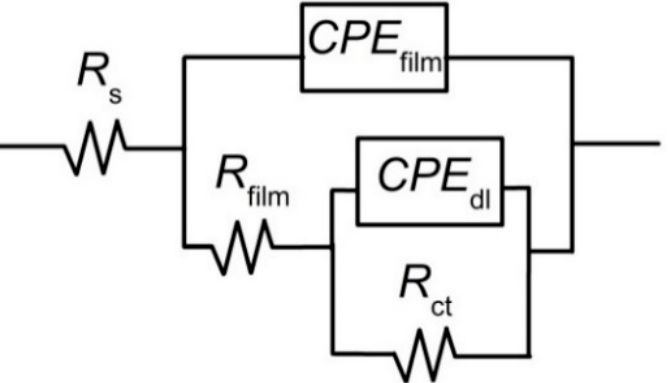
Figure 6. EEC with two time constants proposed to model the EIS response of the Al 10 Cr 30 Fe 25 Mn 30 Ti 5 HEA. After the fitting of the EIS experimental data with the proposed EEC, the following fitting parameters were gathered in Table